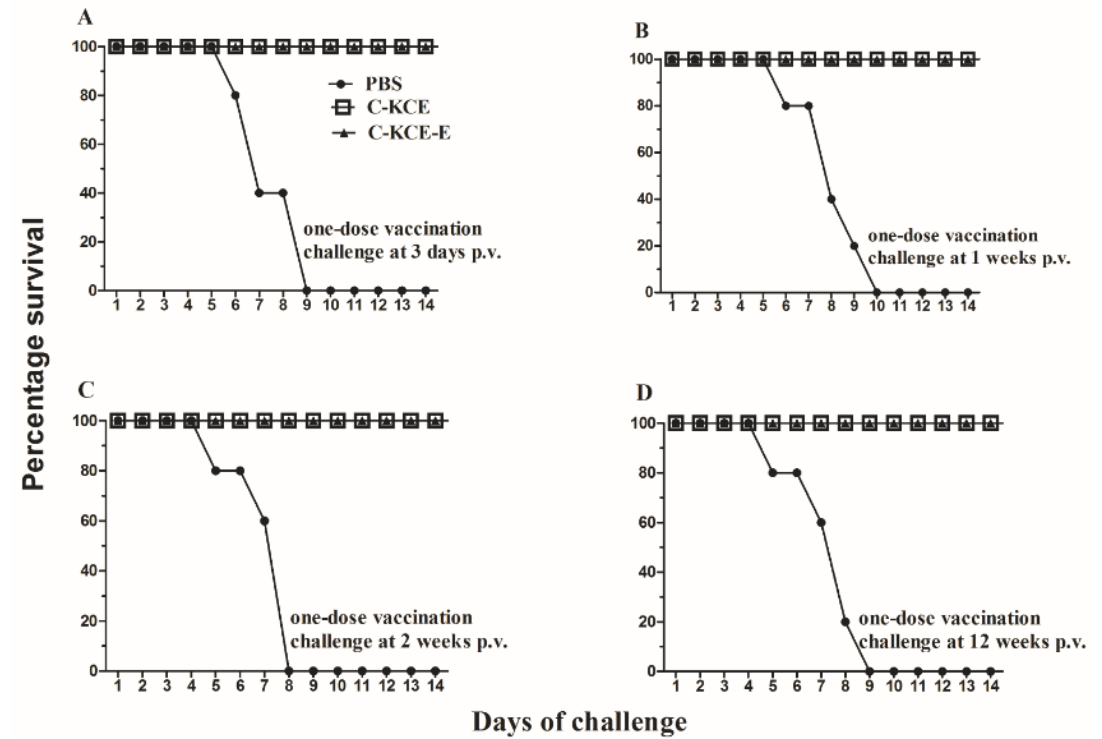
Figure 6. Protective efficacy of C-KCE-E against lethal DEV challenge. Groups of five ducks were inoculated subcutaneously with 10 5 PFU of C-KCE-E, 10 5 PFU of C-KCE or with PBS as a control, then intramuscularly challenged with 100-fold duck lethal dose (DLD ) virulent DEV at three days ( A ), one week ( B ), three weeks ( C ) or 12 weeks ( D ) 50 postvaccination (p.v.), respectively. Ducks were monitored daily for 14 days after challenge.